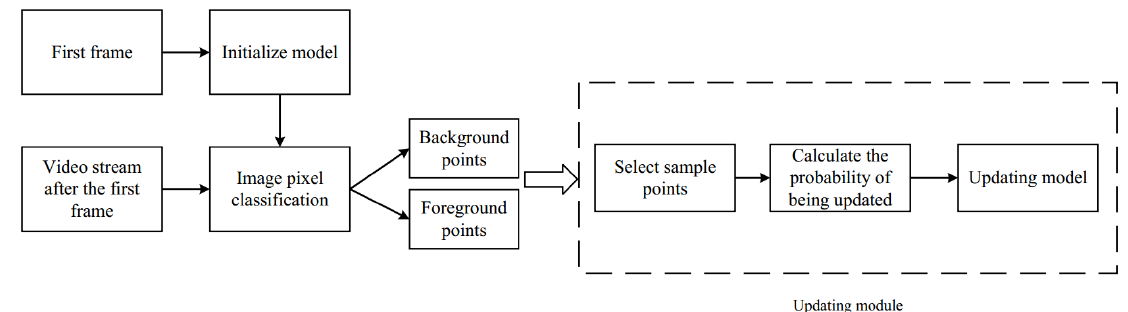
Figure 2. The overview of ViBe algorithm. Given a UAV video stream, the first step of ViBe is to initialize the background. After initialization of the background model at the first frame, the algorithm begins extracting foreground at the second frame. For updating model, sample points are selected randomly, and then the probability of updating is